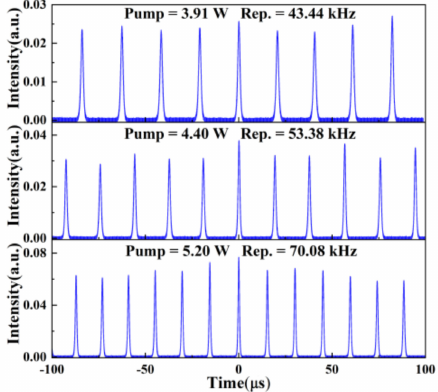
Figure 5. Temporal pulse sequences at different pump powers.